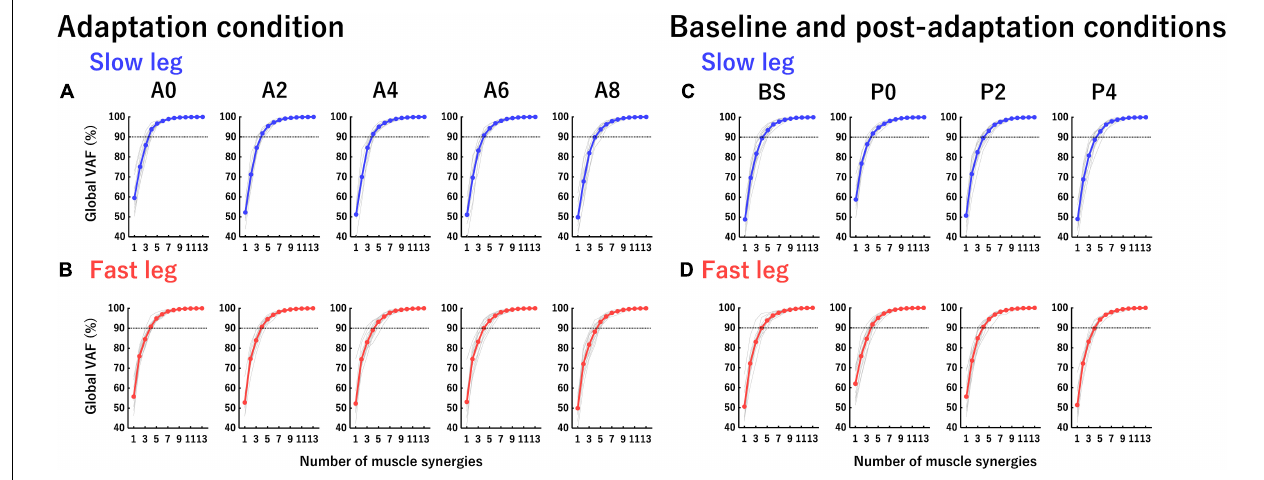
FIGURE 3 | Global variability accounted for (VAF) curves in each leg at each section. The vertical axis indicates global VAF (%) and the horizontal axis indicates the number of muscle synergies. Horizontal dotted lines at 90% VAF indicate the threshold of global VAF. (A,B) Global VAF curves of the slow leg and fast leg at each section in the adaptation condition. (C,D) Global VAF curves of the slow leg and fast leg at each section in the baseline and post-adaptation conditions. Thin gray curves indicate the global VAF curve of each participant and colored curves (blue and red) indicate the averaged global VAF curves from all